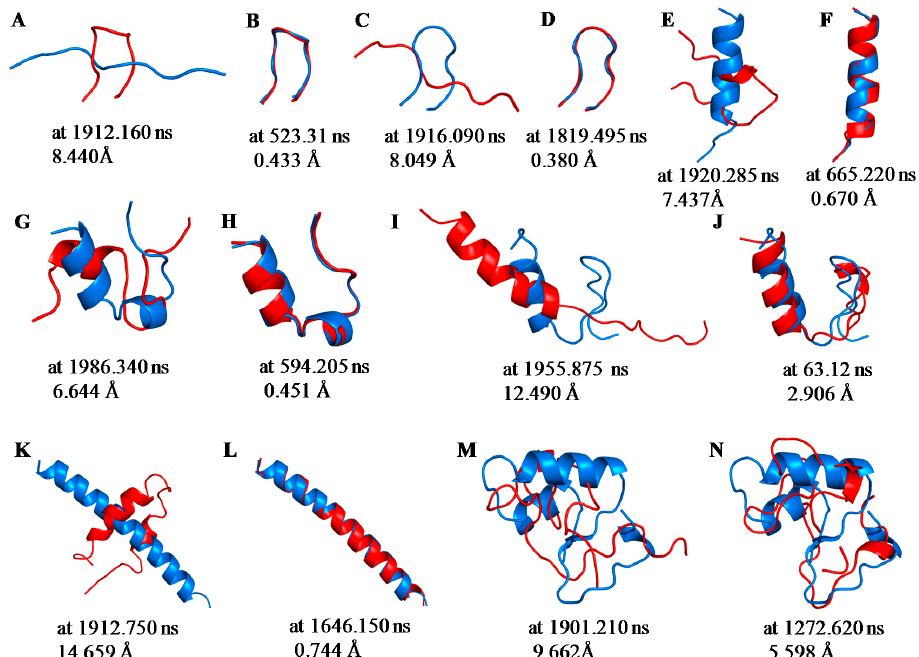
Figure 2. Snapshots at the time of maximum ( A , C , E , G , I , K , M ) and minimum ( B , D , F , H , J , L , N ) RMSD values. The experimentally determined structures (blue) and calculated structures (red) of chignolin ( A , B ); CLN025 ( C , D ); 2I9M ( E , F ); Trp-cage ( G , H ); FSD-1 ( I , J ); HPH ( K , L ) and crambin ( M , N ) are illustrated along with the simulation time and the RMSD values.